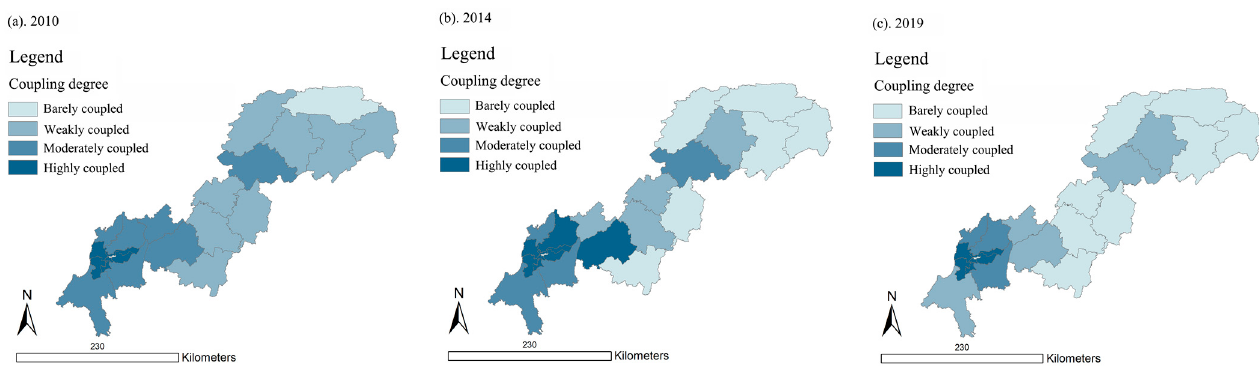
Figure 9. Spatial distribution of coupling degree in the Three Gorges Reservoir Area (Chongqing section) in year 2010, 2014, and 2019 (presented in subfigure a – c , respectively). Sources: Calculation results of the CCD model.